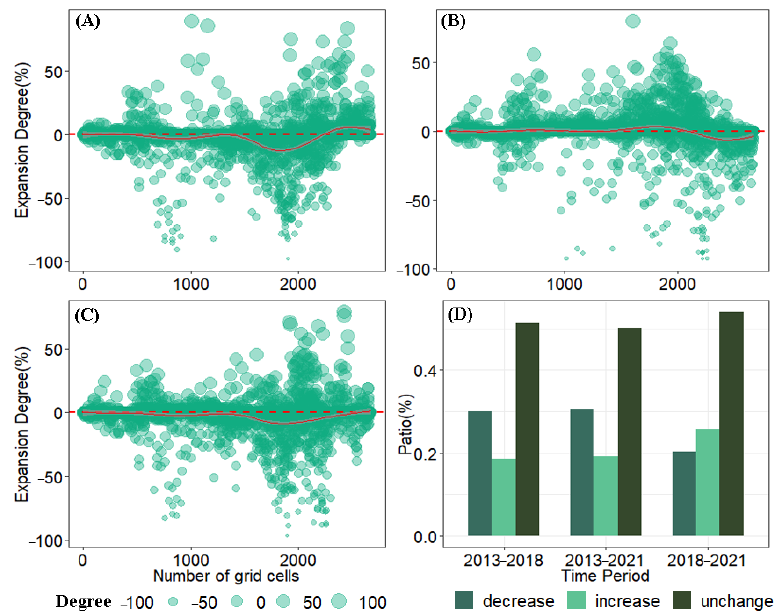
Figure A6. Plot showing the expansion of mudflat mariculture in the study area at the grid scale including ( A ): 2013–2018, ( B ): 2018–2021, ( C ): 2013–2021, and ( D ): Patio changes in mudflat mariculture during the different periods.